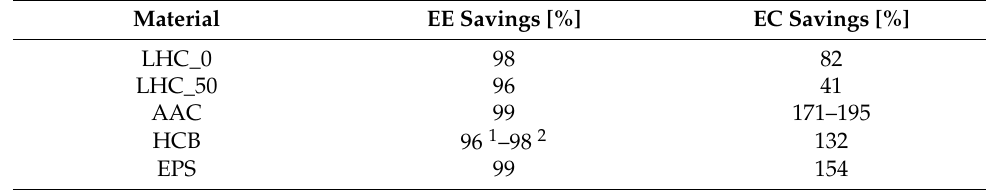
Figure 2. EE and EC values of all LHC buildings (based on Table 2), compared to conventional materials buildings. ( a ) EE; ( b ) EC. * is based on [33], and ** is based [42]. Table 3. The savings in EE and EC relative to a building made of LHC_100 (e.g., LHC_0/LHC_100).